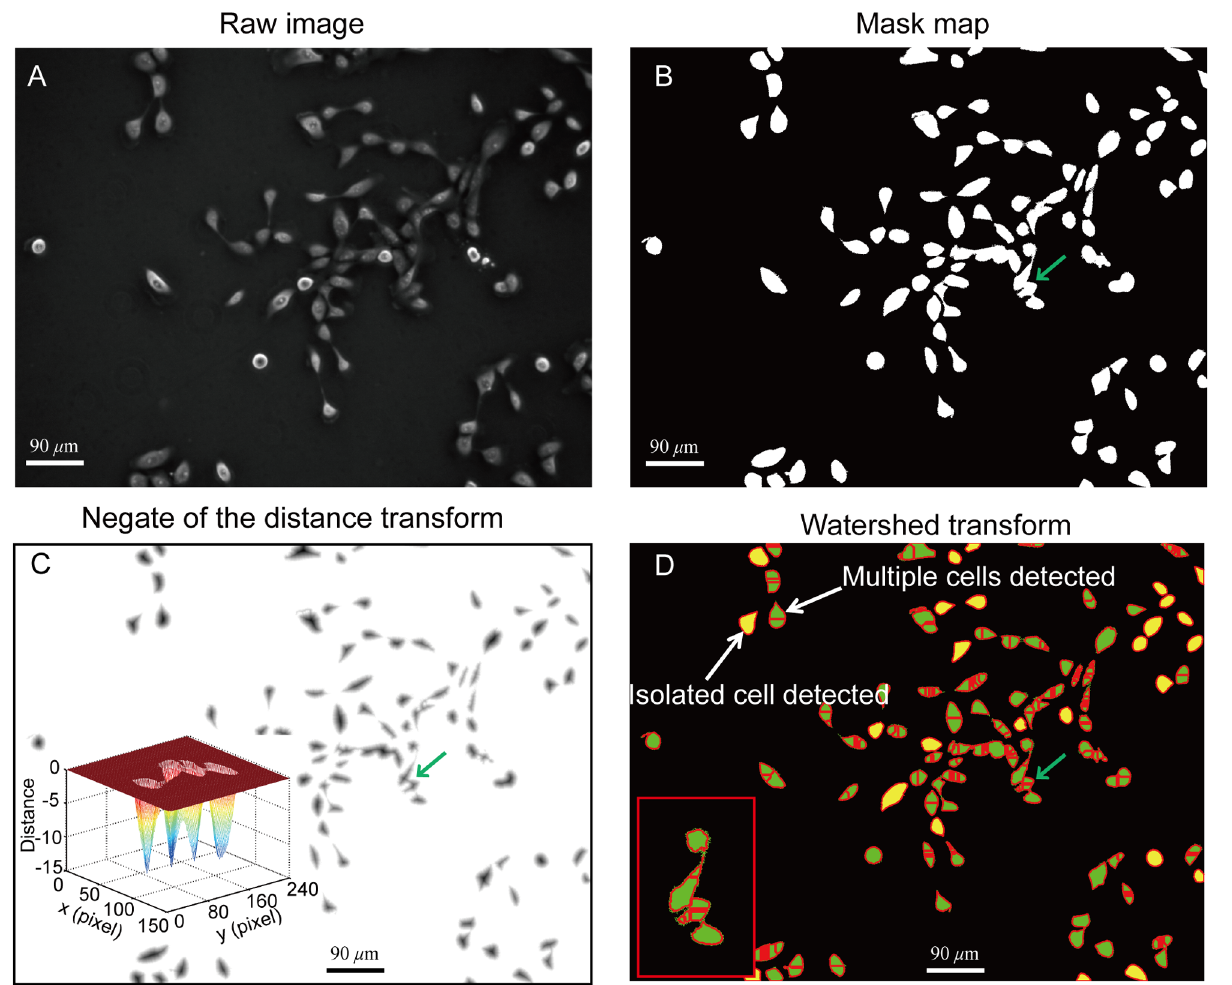
Fig 5. Segmentation of the clustered cells using the watershed method. (A) Raw negative phase contrast image. (B) Preliminarily detected mask map with the thresholding method (threshold = 45). (C) Negate of the distance transform. The inset shows the mesh plot of an area marked by a green arrow. (D) Watershed transform for the detection and segmentation of the clustered cells. The yellow masks are detected isolated cells and the green masks are detected clustered cells. The inset is the enlarged area marked by a green arrow, where four cells are aggregated. The watershed method detected eight cells in the